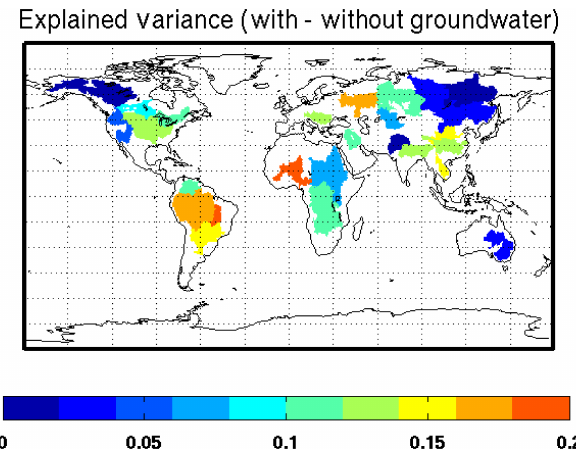
Figure 6. The differences between the explained variance values from WGHM with and without